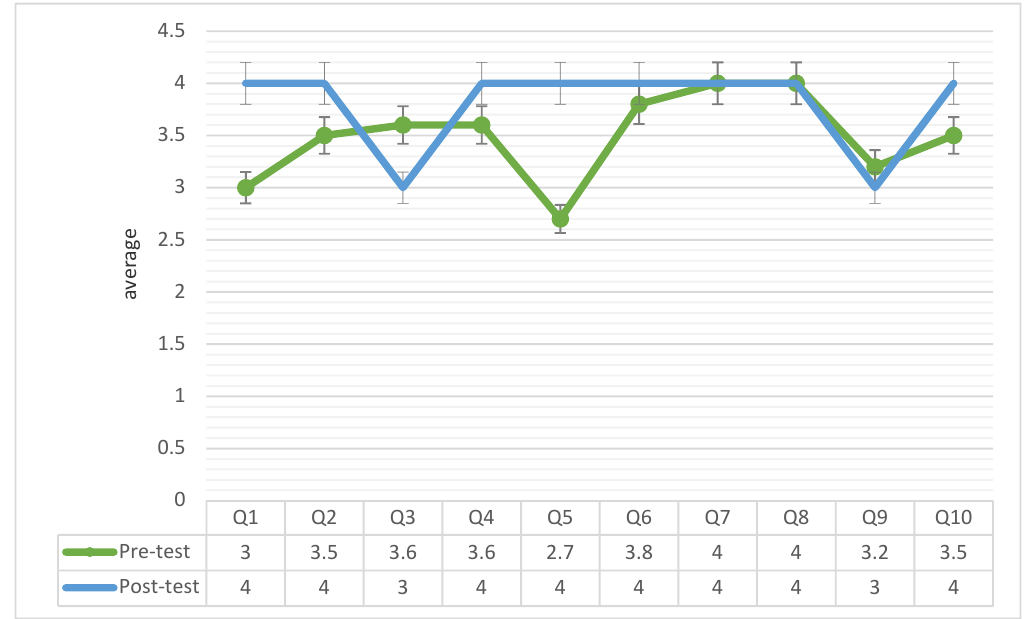
Figure 3. Mean value of the effectiveness test at the pre-test and post-test. This makes several points to be able to create immersion in this exposure therapy. In the Appendix A of this paper, the AIVE questionnaire was reported (Table A1). The use of visual interactions was done with Google VR SDK GvrControllerPointer, via the point pointer generated by the SDK. The pointer in this research is used as a virtual control on the path of player interaction in a virtual environment. The pointer had a working principle where at a 30-degree viewing angle, it would run automatically, and if at ≥ a 30-degree viewing angle, it would stop walking (Figure 4). The use of frame rates on the camera was <130 fps to produce a comfortable visual appearance when used. The frames per second (fps) is the rate of recurrence at which successive illustrations termed frames appear on the screen. This term has something to do with film and video cameras, computer graphics, and motion capture systems. The fps setting in this simple VR simulation using smartphones and Google Cardboard allows the handphone to become a screen display and graphic rendering device tasked with creating an immersive virtual environment. Additionally, as boosting factor of sophistication and comfort while providing a more robust virtual environment.